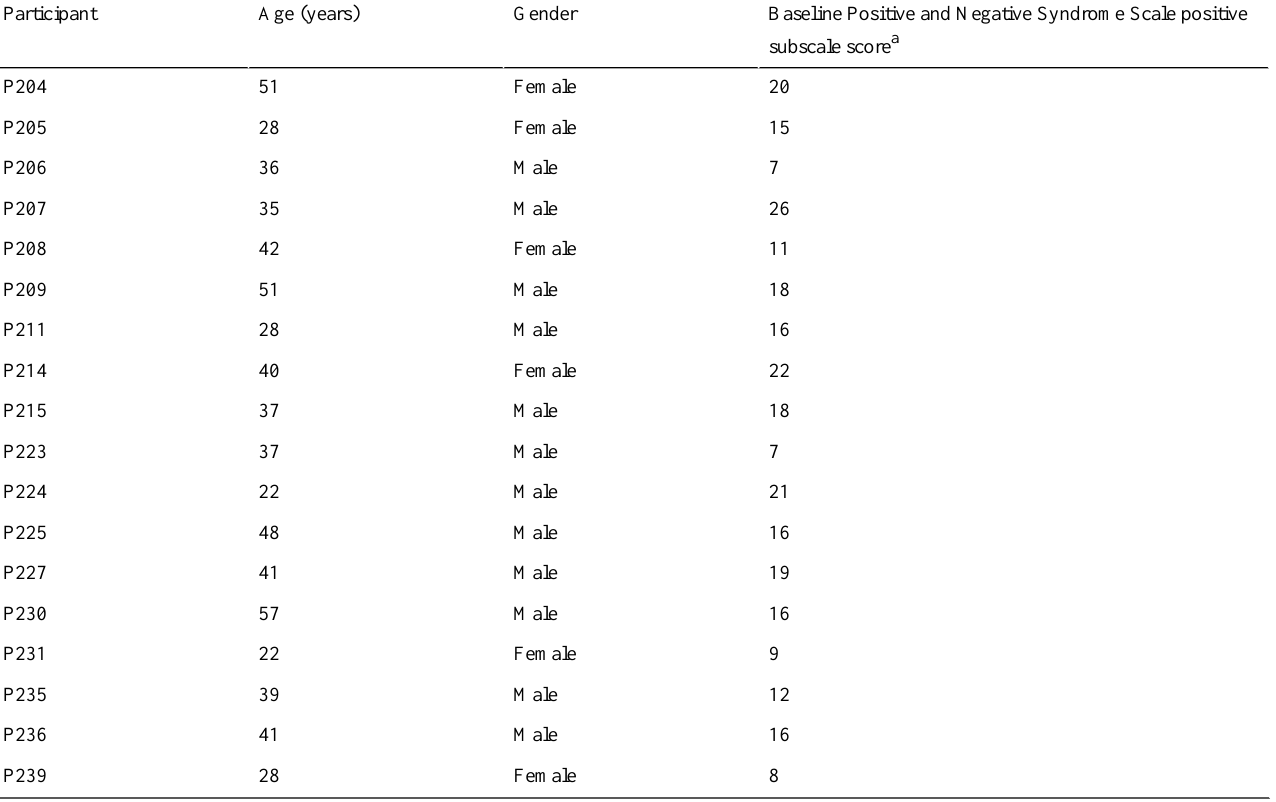
Table 6. Basic characteristics of individual